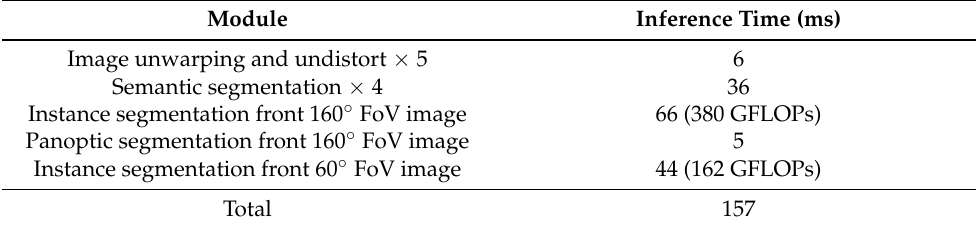
Table 3. Time evaluation of the 2D semantic perception